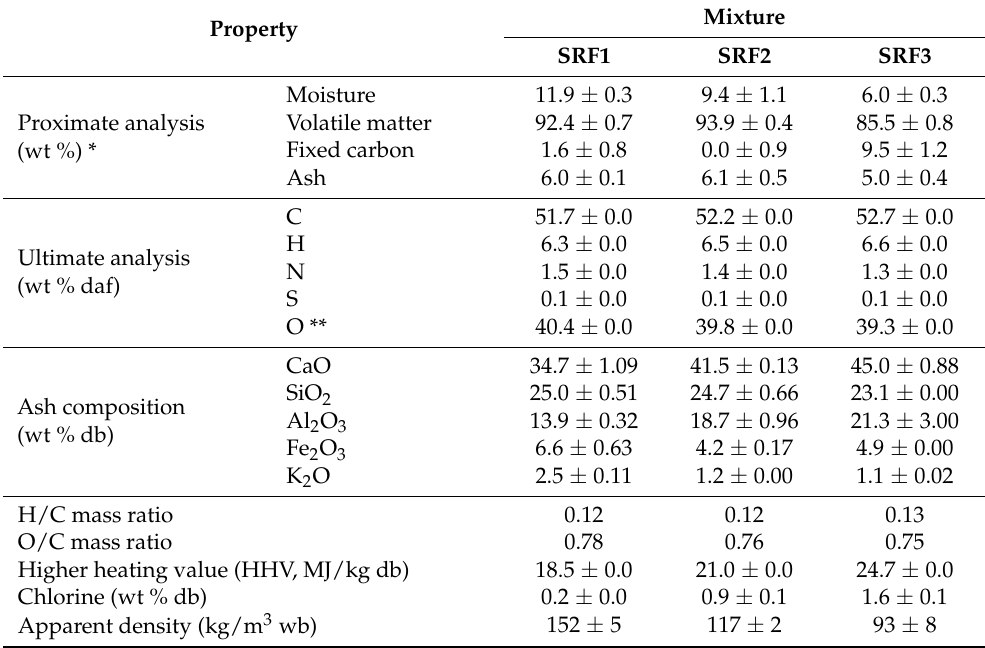
Table 4. Properties of SRFs used in gasification